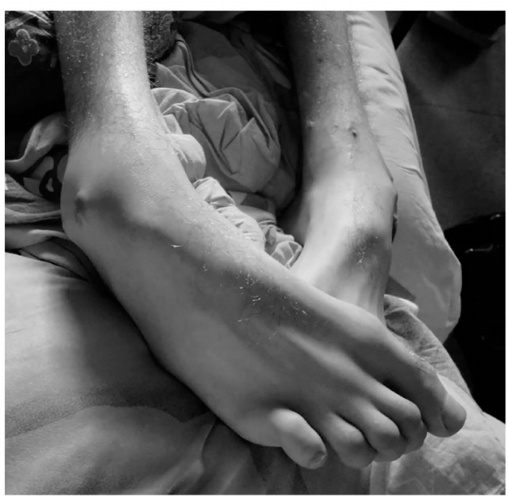
Figure 2. Irreductible equinovarus feet produced by the strong spasticity that the patient developed after suffering brain trauma.